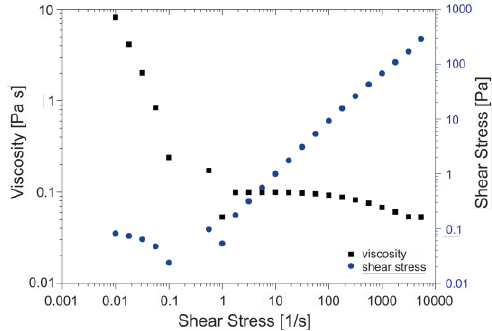
Figure 3. Dynamic viscosity data of the standard solution. Precursor concentration, 0.65 M; PVP concentration, 10 mg/mL.